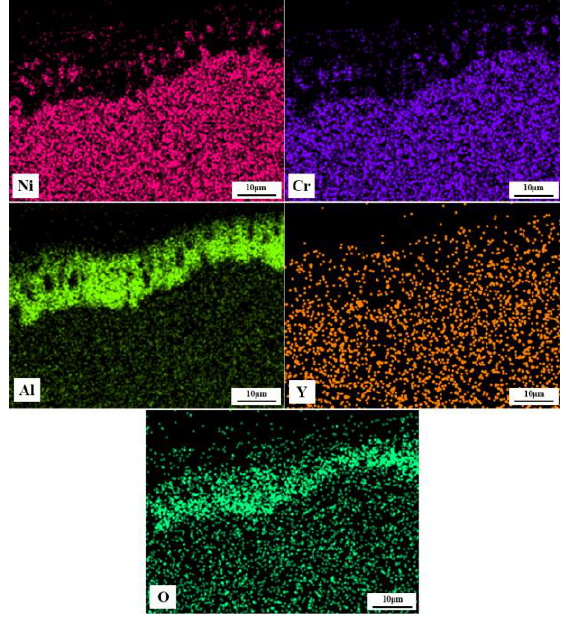
Figure 4. Elements distribution of TS NiCrAl0.5Y coating after oxidation at 1100 ° C for 100 h.